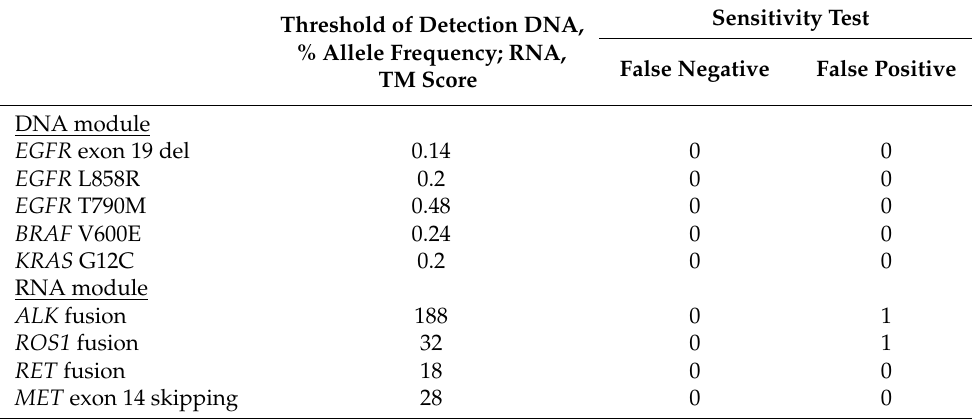
Table 2. Sensitivity test of the compact panel. The number of samples analyzed was 24, except for the ALK false negative (48